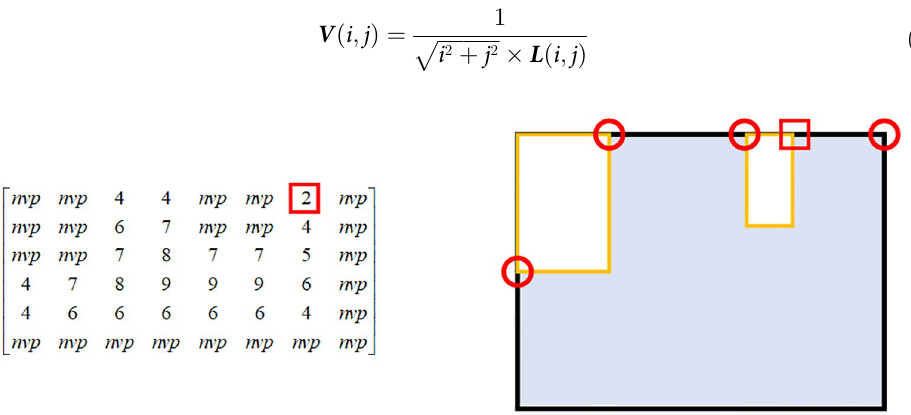
Fig 11. The corner matrix. In the corner matrix, ‘nvp’ means that the position is not valid. The circle indicates the corner position in the current bin, and the square indicates the diamond cave position in the current bin. We can see that the smaller the value of the element, the more suitable the